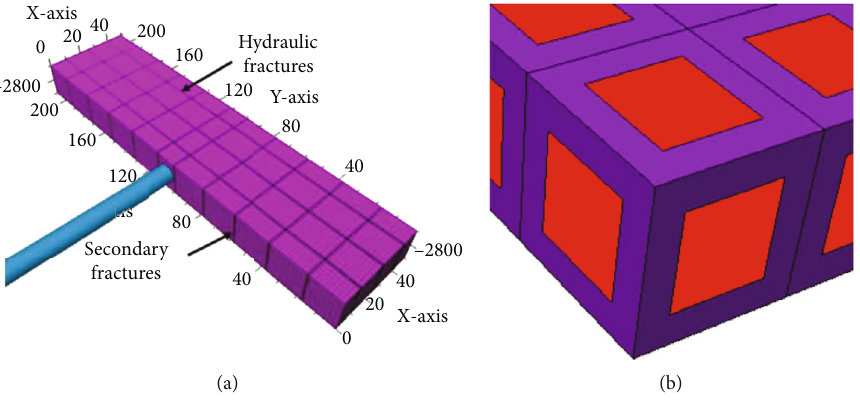
Figure 2: Single-stage fracturing model of dual media. (a) Single-stage fracturing model. (b) Dual medium